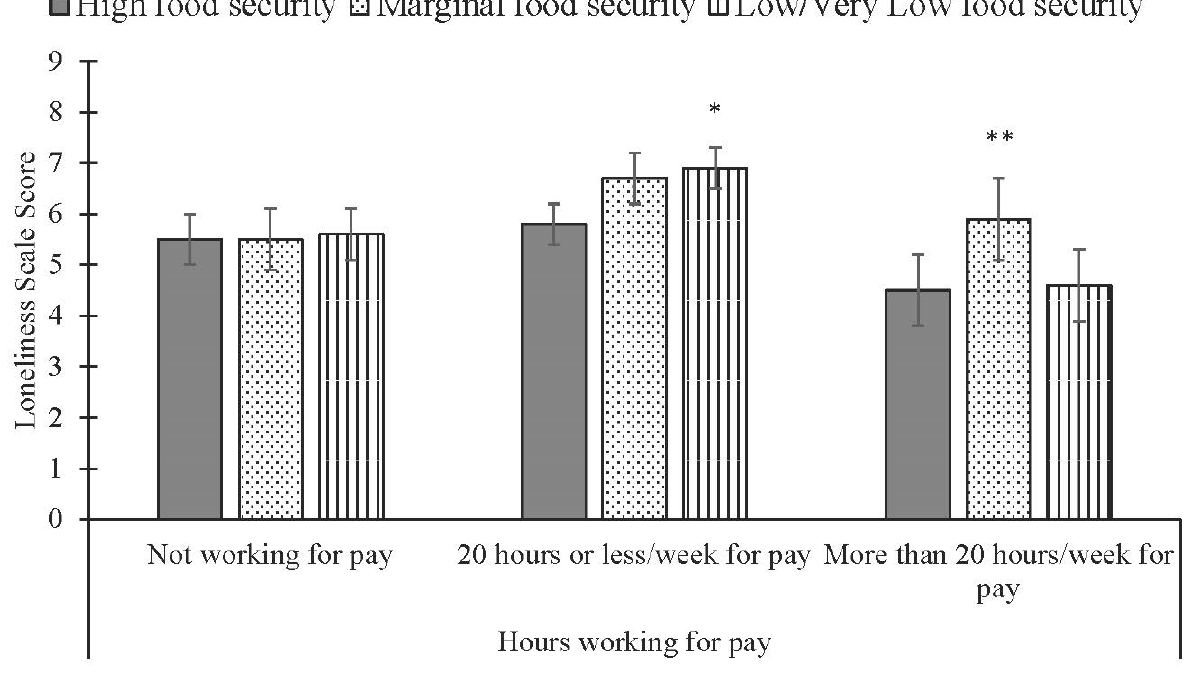
Figure 3. Adjusted mean (SE) loneliness scores by food security status and hours working for pay among full-time undergraduate students. * Indicates significantly different than high food security status at p < 0.01. ** Indicates significantly different than high food security status at p < 0.05; significantly different than low/very low food security status at p < 0.05.